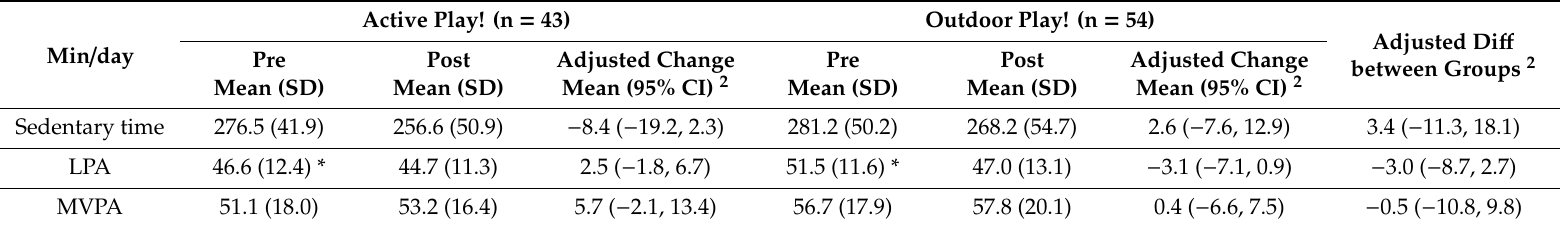
Table 3. Comparison of accelerometer-measured 1 sedentary time and physical activity by intervention type.